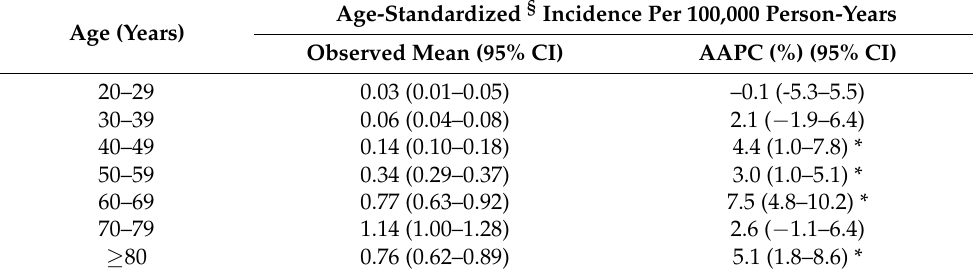
Table 3. Incidence rates and trends for CNS DLBCL in Australian adults by age group at diagnosis between 2000 and